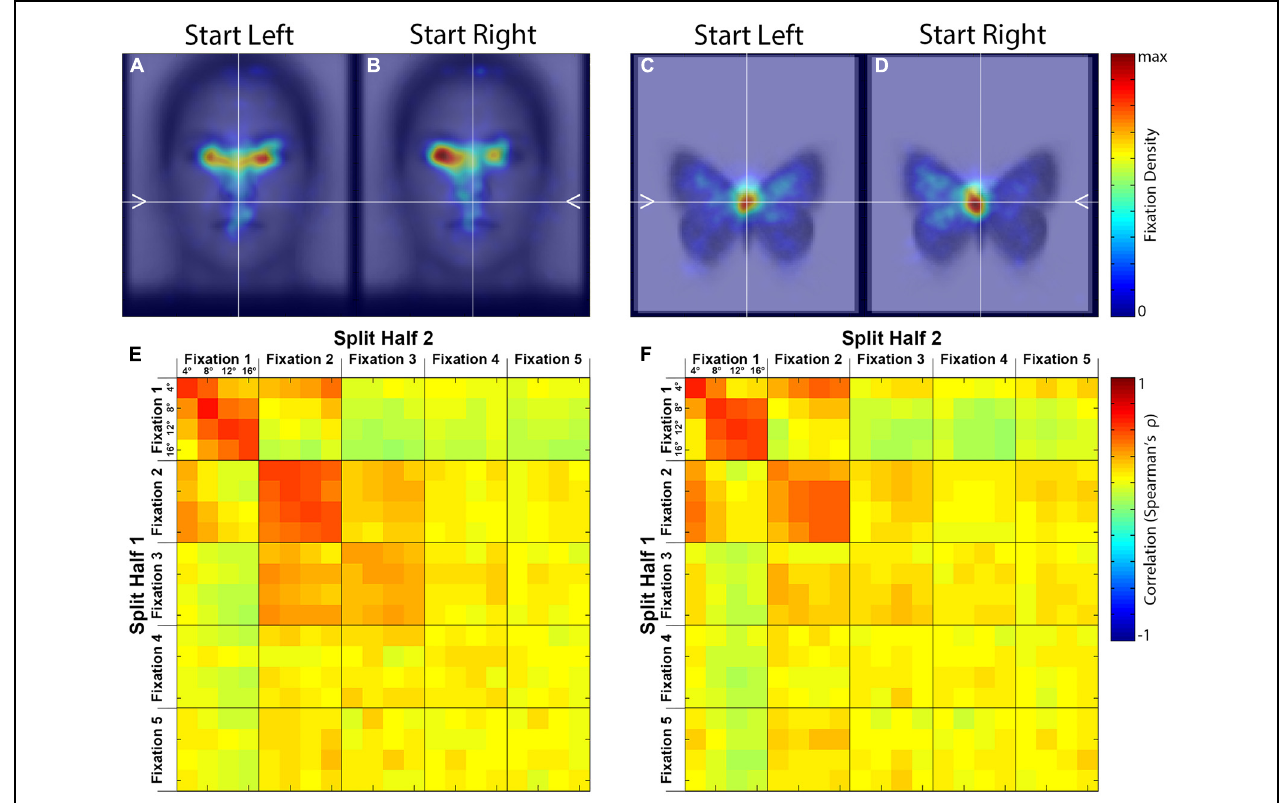
FIGURE 3 | Spatial density maps and similarity matrices. (A–D) Spatial density maps by stimulus category and starting side. These densities reflect the second through fifth ordinal fixations pooled. (E,F) Split-half correlation matrices by ordinal fixation and starting distance for each stimulus category. The correlations are between spatial fixation